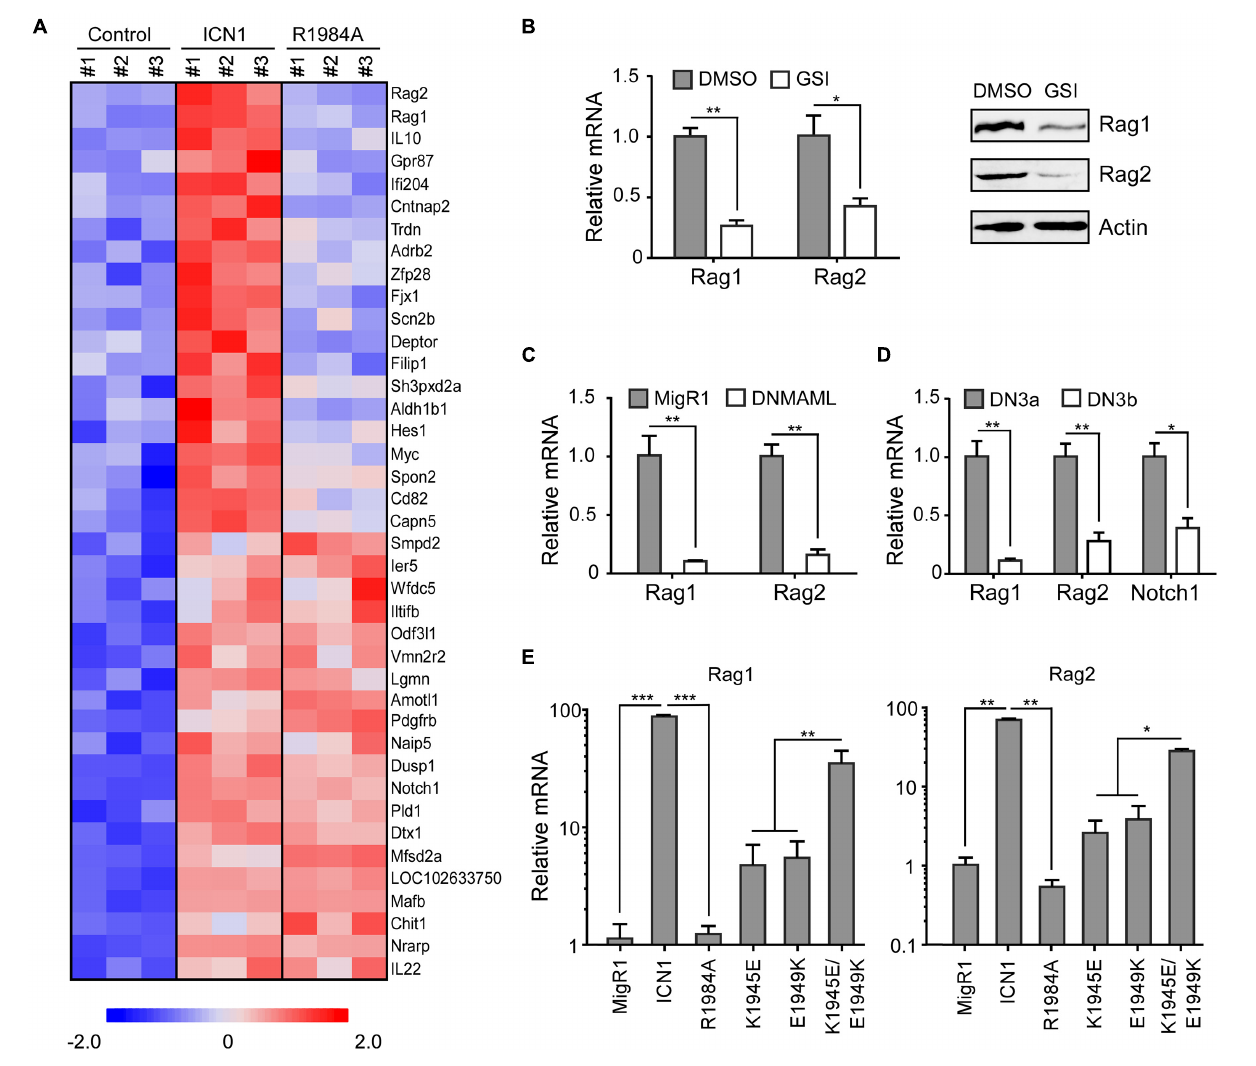
FIGURE 1 | Notch signaling induces Rag1 and Rag2 expression. (A) Identification of Notch1 dimer-dependent target genes. Notch1-dependent genes were determined from a microarray analysis in murine T-ALL T6E cells (GSE97465). Each gene expression is displayed with colored boxes which are scaled in the bottom. ICN1 expression means Notch1 monomer and dimer activation, and R1984A expression denotes only Notch1 monomer activation. Expression data from 20 genes most strictly dependent on the Notch1 dimer and 20 genes equally induced by both Notch1 dimer and monomer are depicted ( p < 0.05). (B) T6E cells were treated with JC-18 (1 µ M) or DMSO for 24 h. Rag1 and Rag2 mRNA and proteins were detected by real-time PCR (left) and immunoblots (right). (C) T6E cells were transduced with DNMAML1 or empty vector MigR1 surrogated with a GFP marker for 24 h. GFP + cells were sorted and subjected to mRNA analysis by real-time PCR. (D) DN3a and DN3b cells were isolated from C57BL/6 mice. Rag1 and Rag2 mRNA, along with positive control Notch1 mRNA, were evaluated by real-time PCR. (E) T6E cells were infected by retroviruses expressing MigR1, WT ICN1, or designated dimerization mutants, then subjected to JC-18 treatment for 24 h.